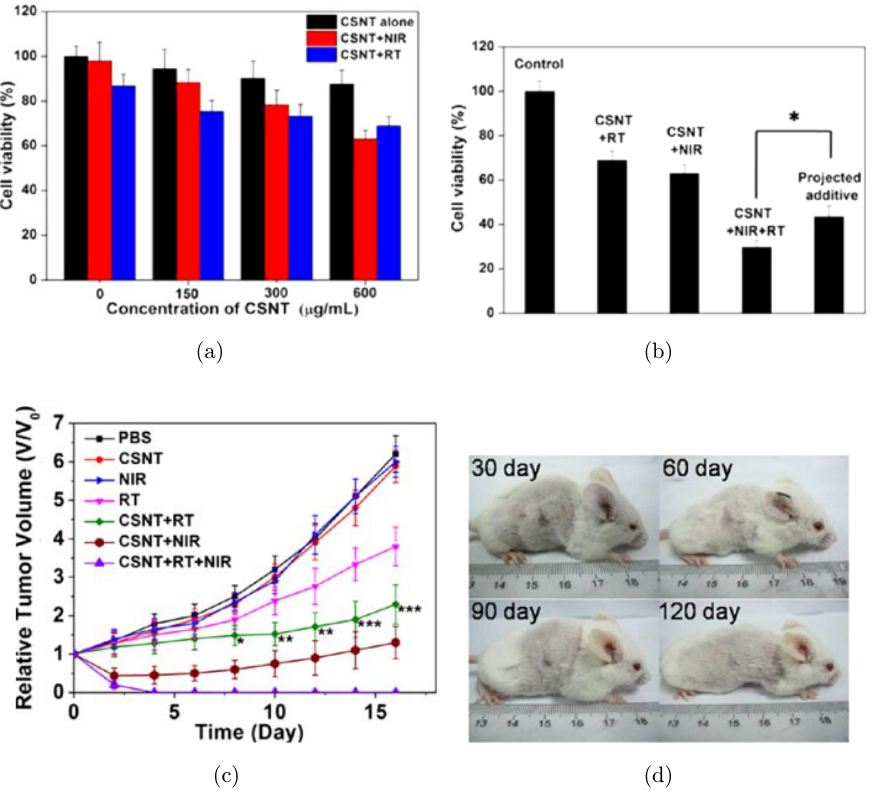
Fig. 7. (a) Quantitative analysis of the cell viability with CSNTs at varied concentrations with or without NIR-laser irradiation and RT. (b) Synergistic therapeutic e®ect of Hela cells that have taken up CSNTs subjected to RT, PTA, and the combined RT/ PTA treatments. (c) Time-dependent tumor growth curves of di®erent groups of mice with various treatments. In all experiments, the power density of 980 nm NIR-laser and the radiation dose used for RT were kept constant at 1.5 W/cm 2 and 6 Gy, respectively. (d) The photographs of mice in 30, 60, 90, and 120 days of treatment (group 7) showing the complete eradication of the tumor and no visible recurrences of the tumors in at least 120 days. (Reprinted with permission from \A core/satellite multifunctional nanotheranostic for in vivo imaging and tumor eradication by radiation/photothermal synergistic therapy". Copyright (2013) American Chemical